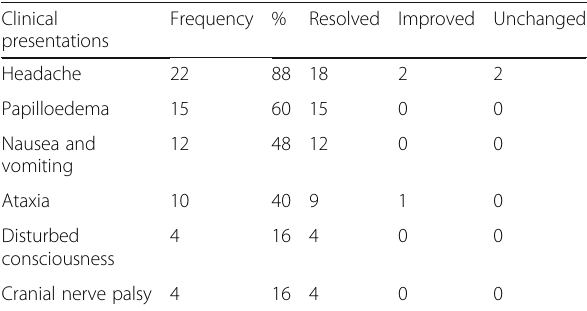
Table 1 Preoperative clinical presentations and their relative post-operative improvement rates Clinical